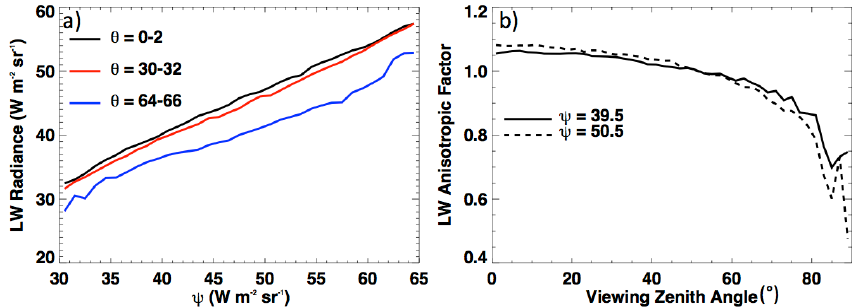
Figure 17. (a) LW radiance against ψ for three θ bins over permanent snow for 30 <(cid:49)T sc < 40K, 240 <T s < 250K, and f = 100%. (b) LW Figure 17. a) LW radiance against ψ for three θ bins over permanent snow for 30 < ∆ T anisotropic factors for ψ = 39.5Wm − 2 sr − 1 and ψ = 50.5Wm − 2 sr − 1 . 240 <T 250 K, and f =100%. b) LW anisotropic factors for ψ =39.5Wm − 2 sr − 1 and ψ =50.5Wm − 2 sr − 1 . s <